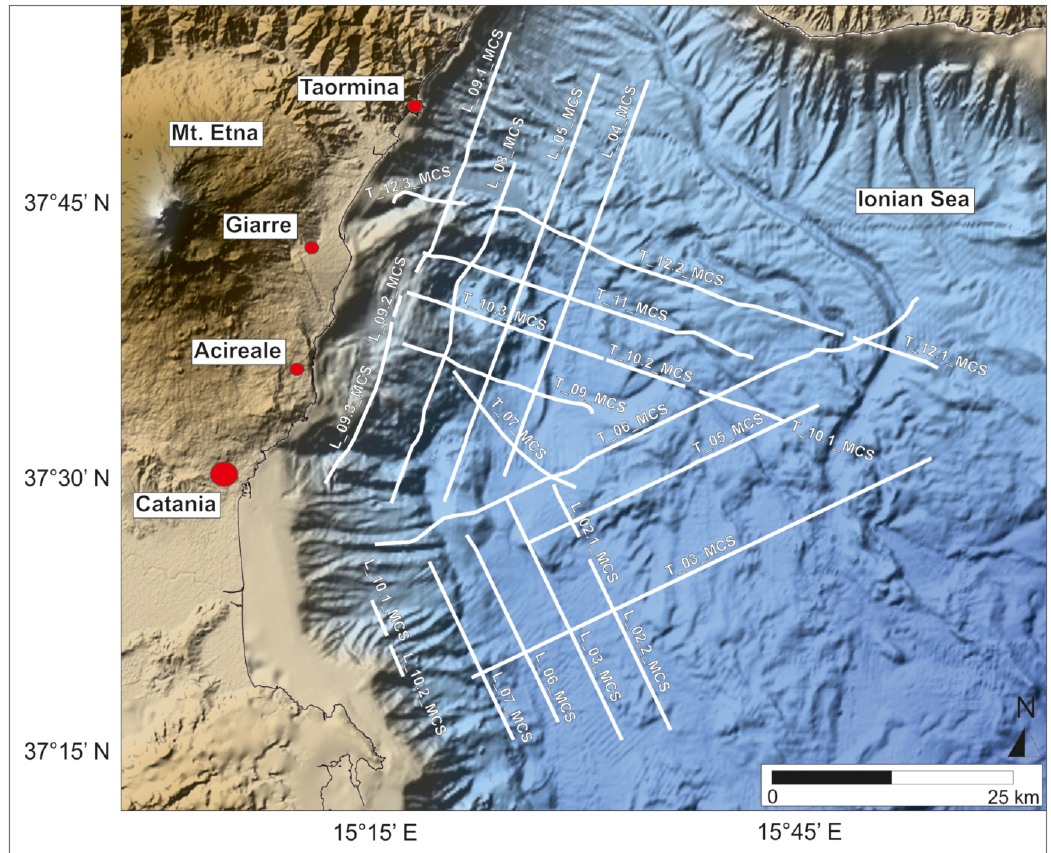
Figure 2. Acquisition map in the Ionian Sea during the TOMO-ETNA cruise on board of the R/V “Sarmiento de